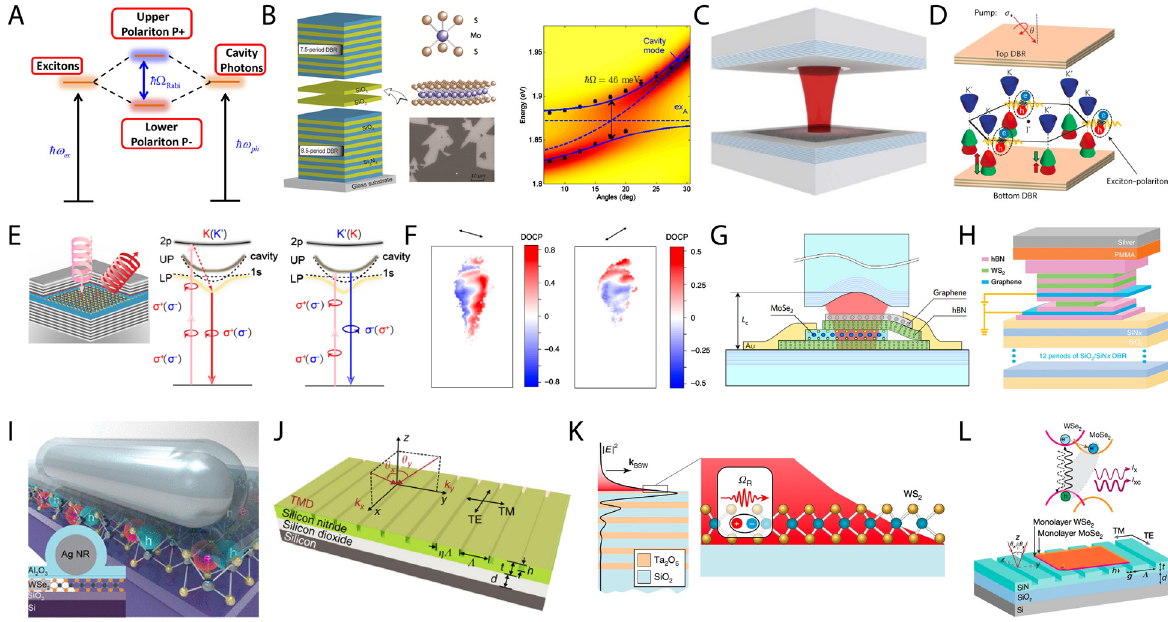
Figure 3: The strong coupling regime in 2D materials-cavity